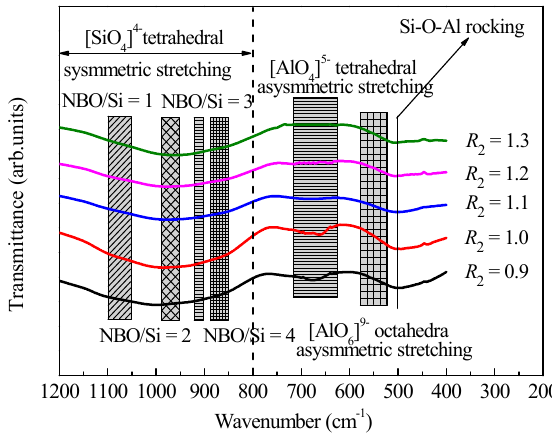
Figure 2. FTIR spectra of smelting slag with the varied basicity.